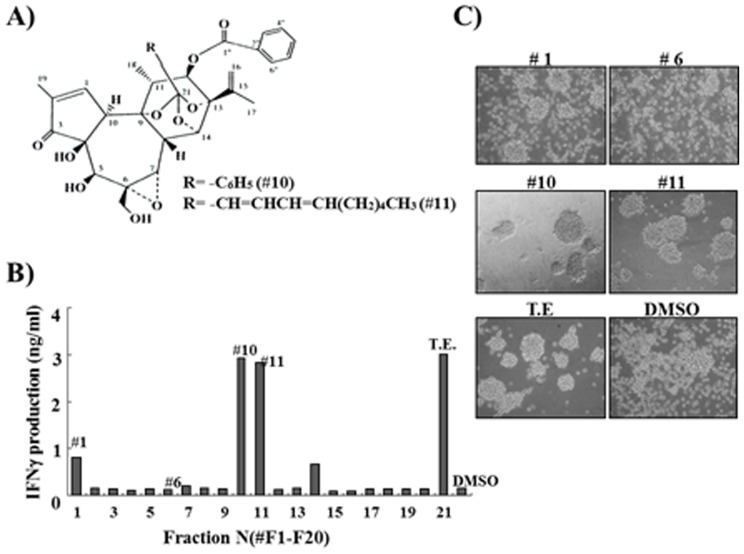
The effects of the flower bud extracts on IFN-γ production and morphological changes. A. The structure of GD-1 and yuanhuacine isolated from the extract of Daphne genkwa plant. B. ELISA-based assay for IFN-γ production. Total extract (TE) and twenty fractions (1 to 20) were treated on NK-92 and IFN-γ secretion was analyzed by ELISA. Fraction number 10 (#10) and 11 (#11) indicate GD-1 and yuanhuacine, respectively. All ELISA data are representative of at least three independent experiments. C. NK-92 cell morphologies were analyzed microscopically after the treatment of flower extracts. The addition of GD-1 (#10), yuanhuacine (#11) and TE have induced the morphological changes of NK-92 cells, which matches with the pattern of IFN-γ production.